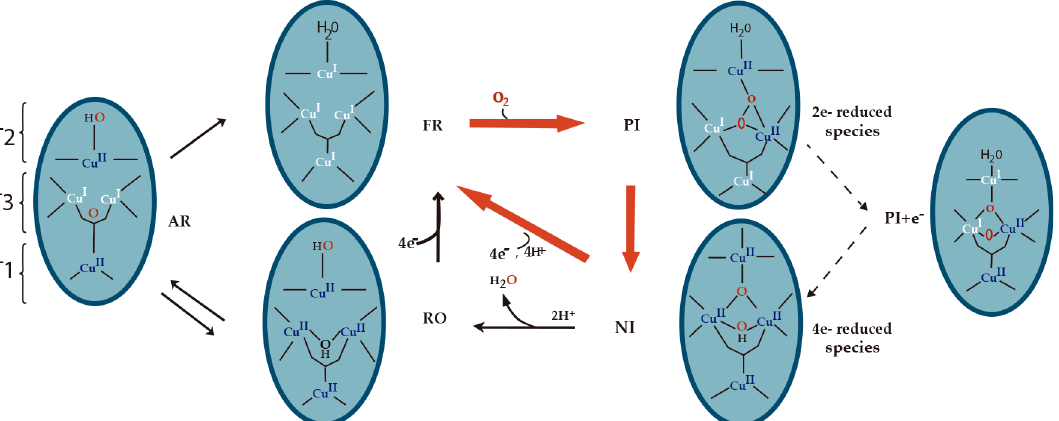
Fig 3. Mechanism of O 2 reduction to water by the MCOs. Red arrows indicate fast reactions; black arrows indicate steps that are part of catalysis.